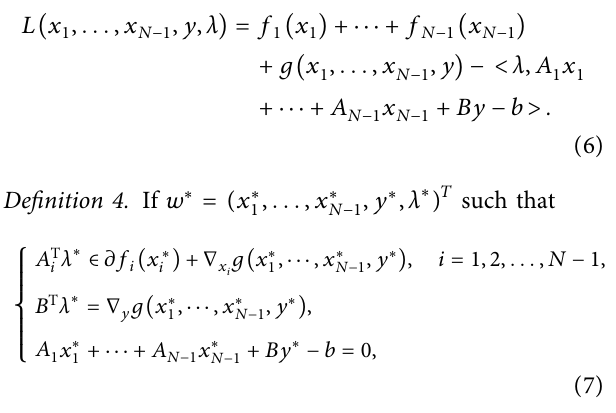
, , x 0 , y 0 ) T and λ 0 1 2